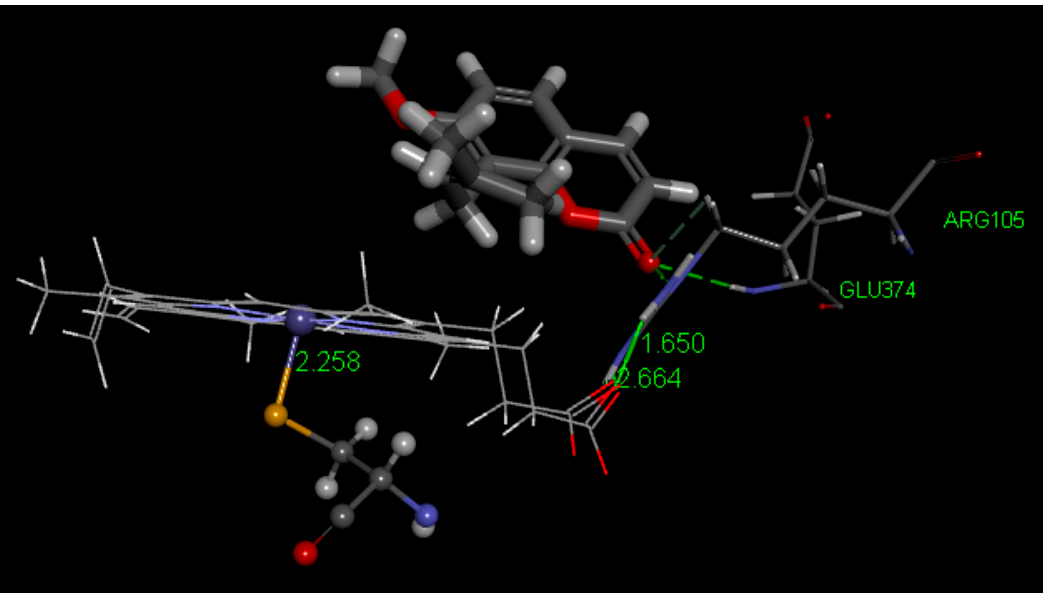
Figure 15. Pose 3 after docking of osthole was also selected to run DFT calculations.